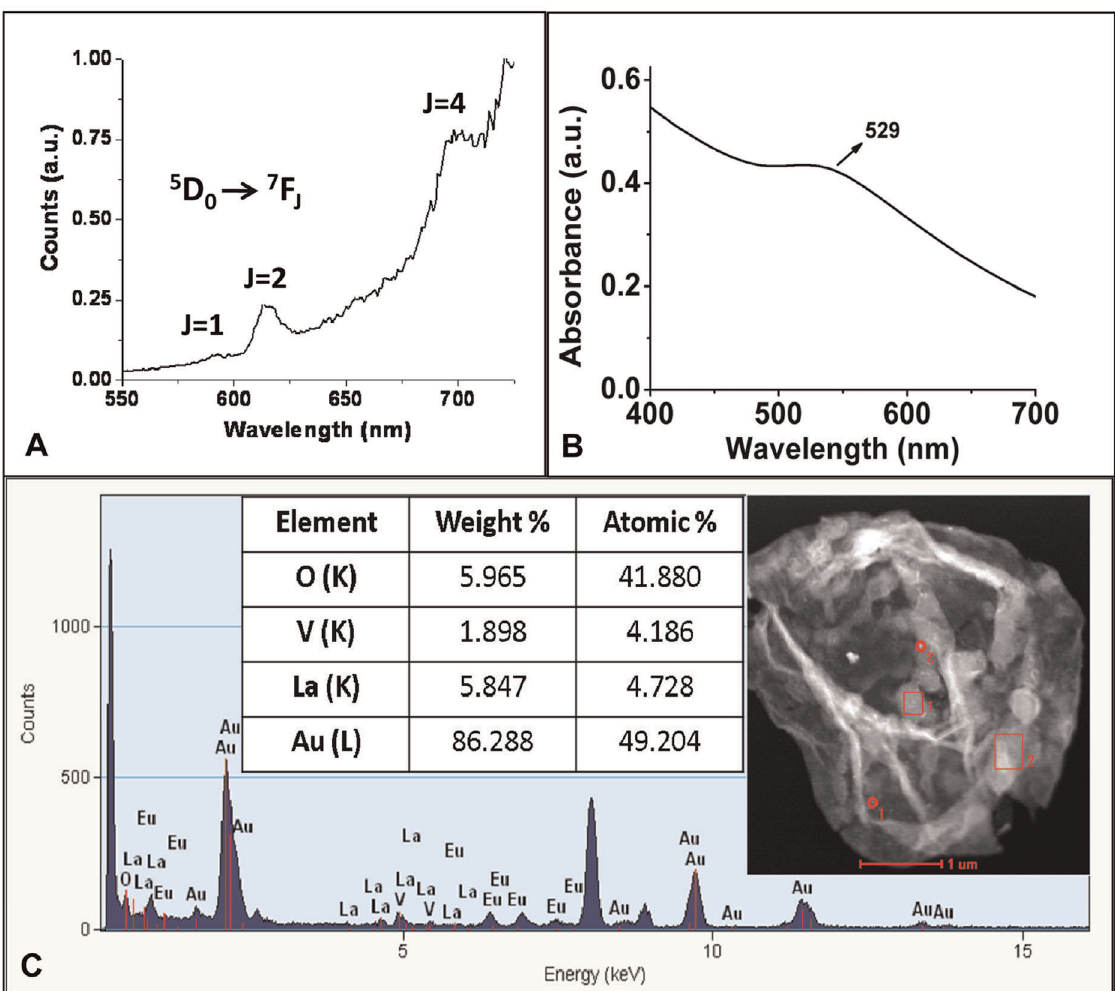
Figure 5. Optical properties of PSS/PAH capsules co-loaded with two types of nanoparticles. (a) Photoluminescence emission spectrum, (b) UV-Vis absorption spectrum and (c) EDX analysis of PSS/PAH capsules co-loaded with Au and LaVO 4 :Eu 3 + (5%) nanoparticles.